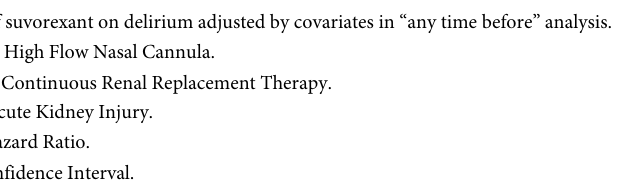
Dexmedetomidine 0.04 Effect of suvorexant on delirium adjusted by covariates in “any time before” analysis.